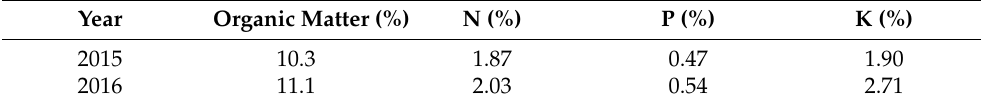
Table 3. Chemical composition of farmyard rotted manure used in the